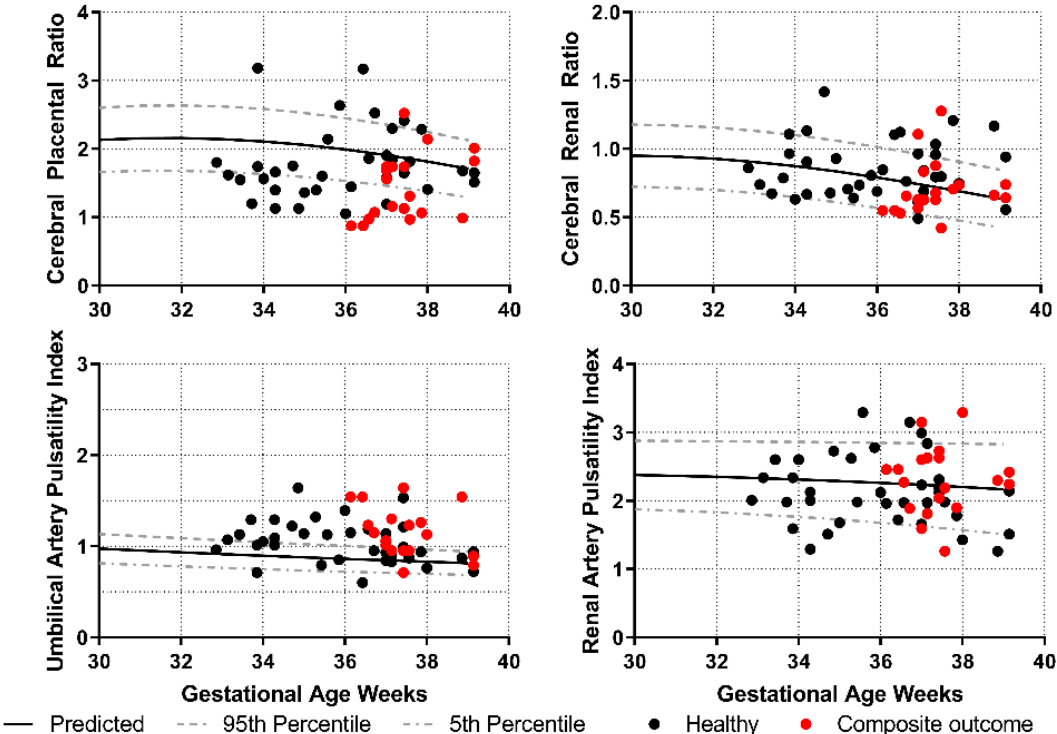
Figure 2. Doppler parameters and distribution by neonatal outcome.